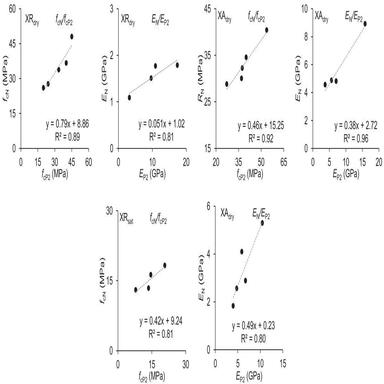
Correlation for fc and E mechanical parameters for dry (above) and saturated (bellow) XR and XA specimens.